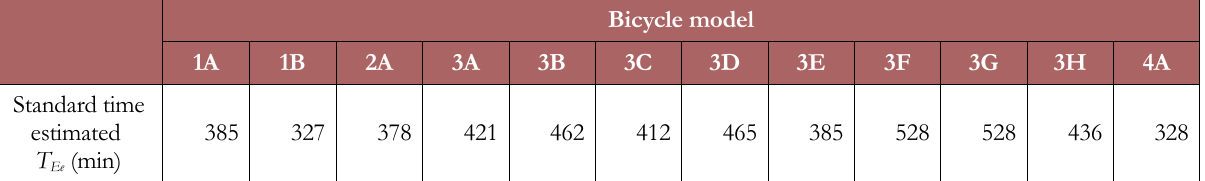
Table 21. Standard times estimated for bicycle